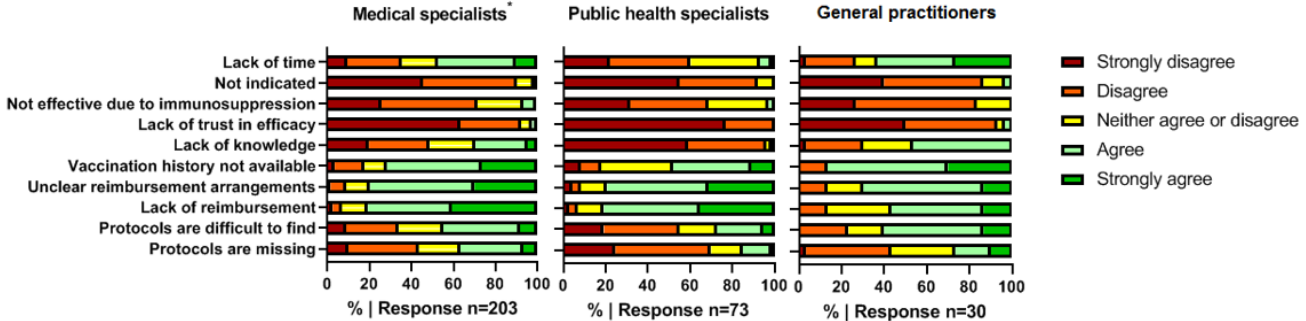
Figure 1. Barriers to indicating medically indicated vaccines. * Including physician assistants and nurse